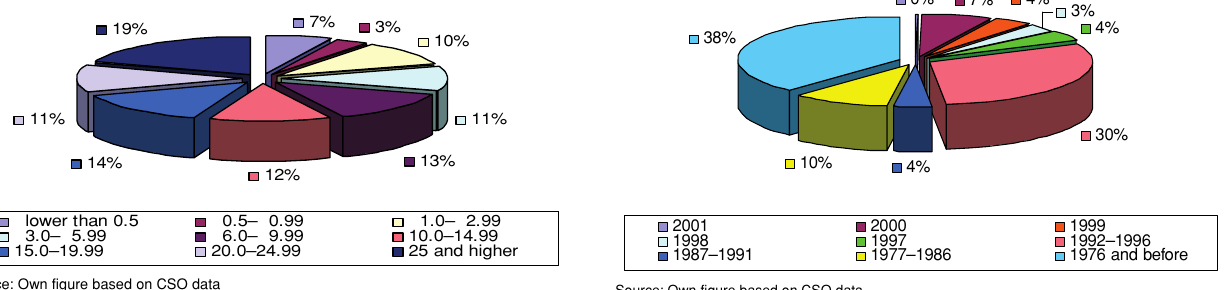
Figure1: Distribution of apple orchards inWest Transdanubia according to